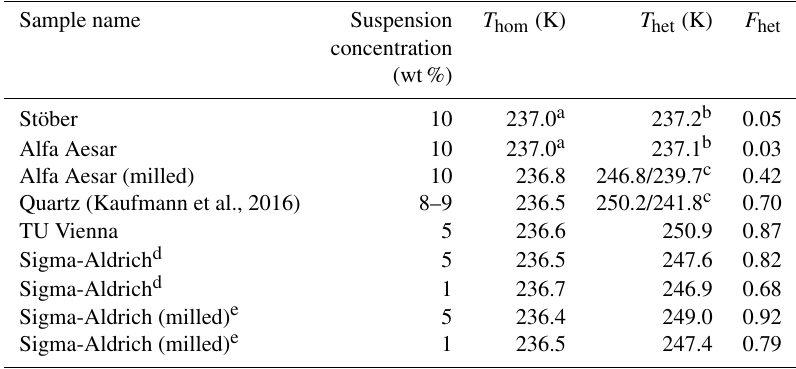
Table 1. Comparison of IN efficiency (in pure water) of various quartz and amorphous silica particles based on emulsion freezing experi-